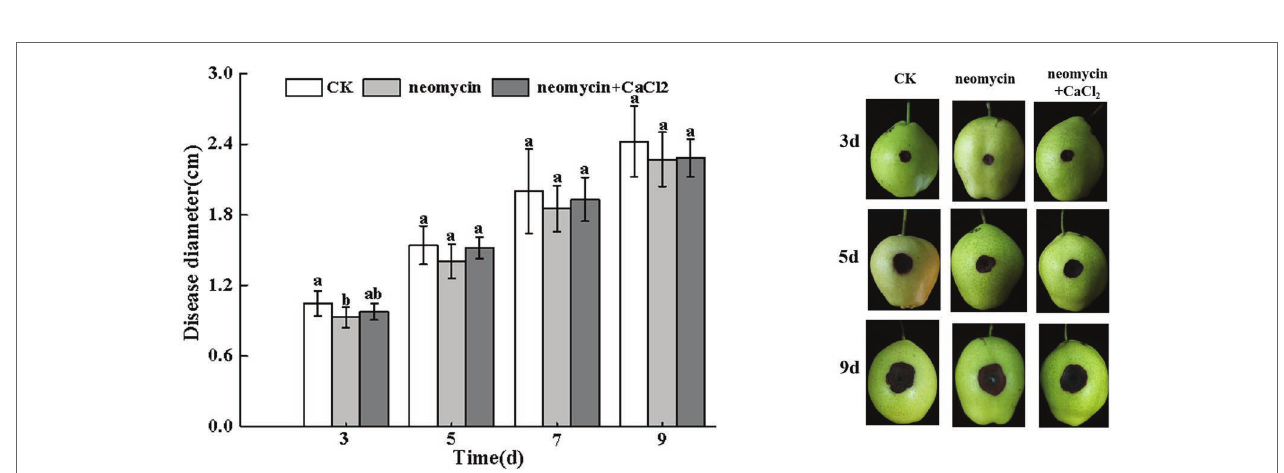
FIGURE 7 | Effects of neomycin and exogenous Ca 2+ on the black spots of Zaosu pear. Lesions were measured at 3, 5, 7, and 9 days, respectively. Vertical lines indicate standard error (± SE ) of the means. Different letters indicate significant differences between treatments according to Duncan’s multiple range test ( p < 0.05).